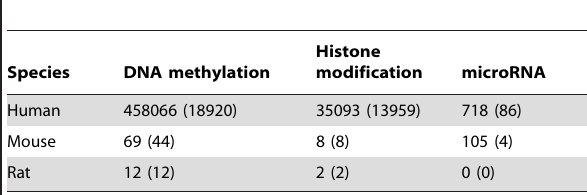
Table 1. Number of epigenetic records and genes in PEpiD, with gene numbers in